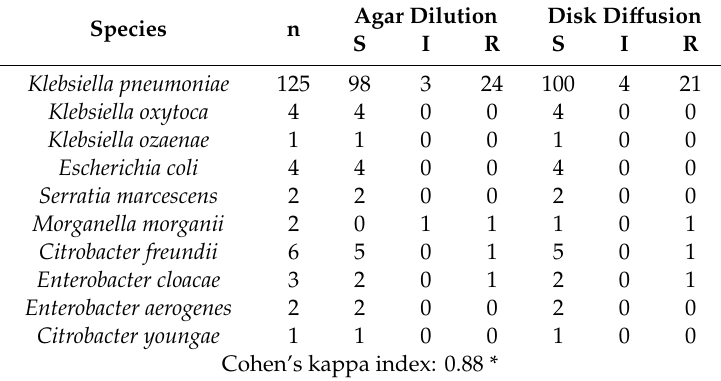
Table 2. Agreement between agar dilution and disk di ff usion methods.